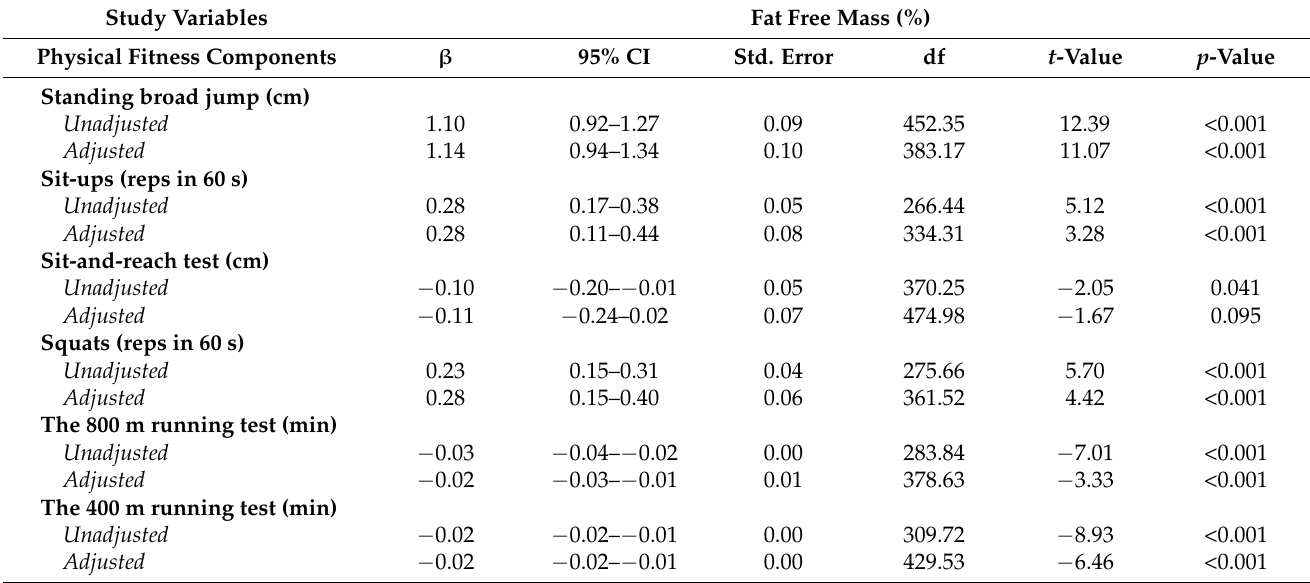
Table 3. The mixed model estimates of the association between the fat free mass with other physical fitness components (N =